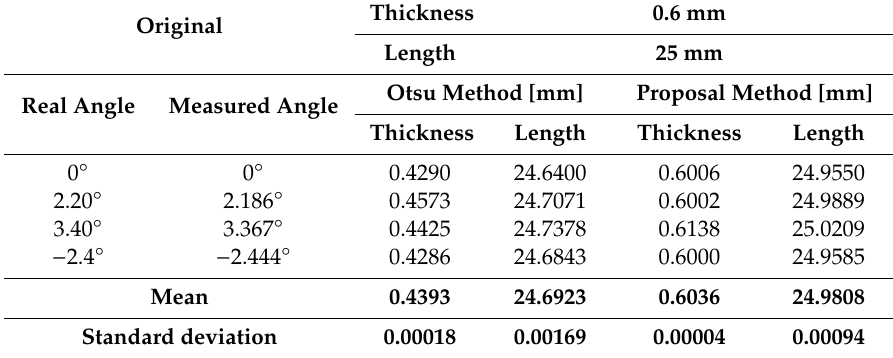
Table 1. A performance comparison between the Otsu method and the proposed curvature-based binarization method for the cutting blade dimensions’ measurement.